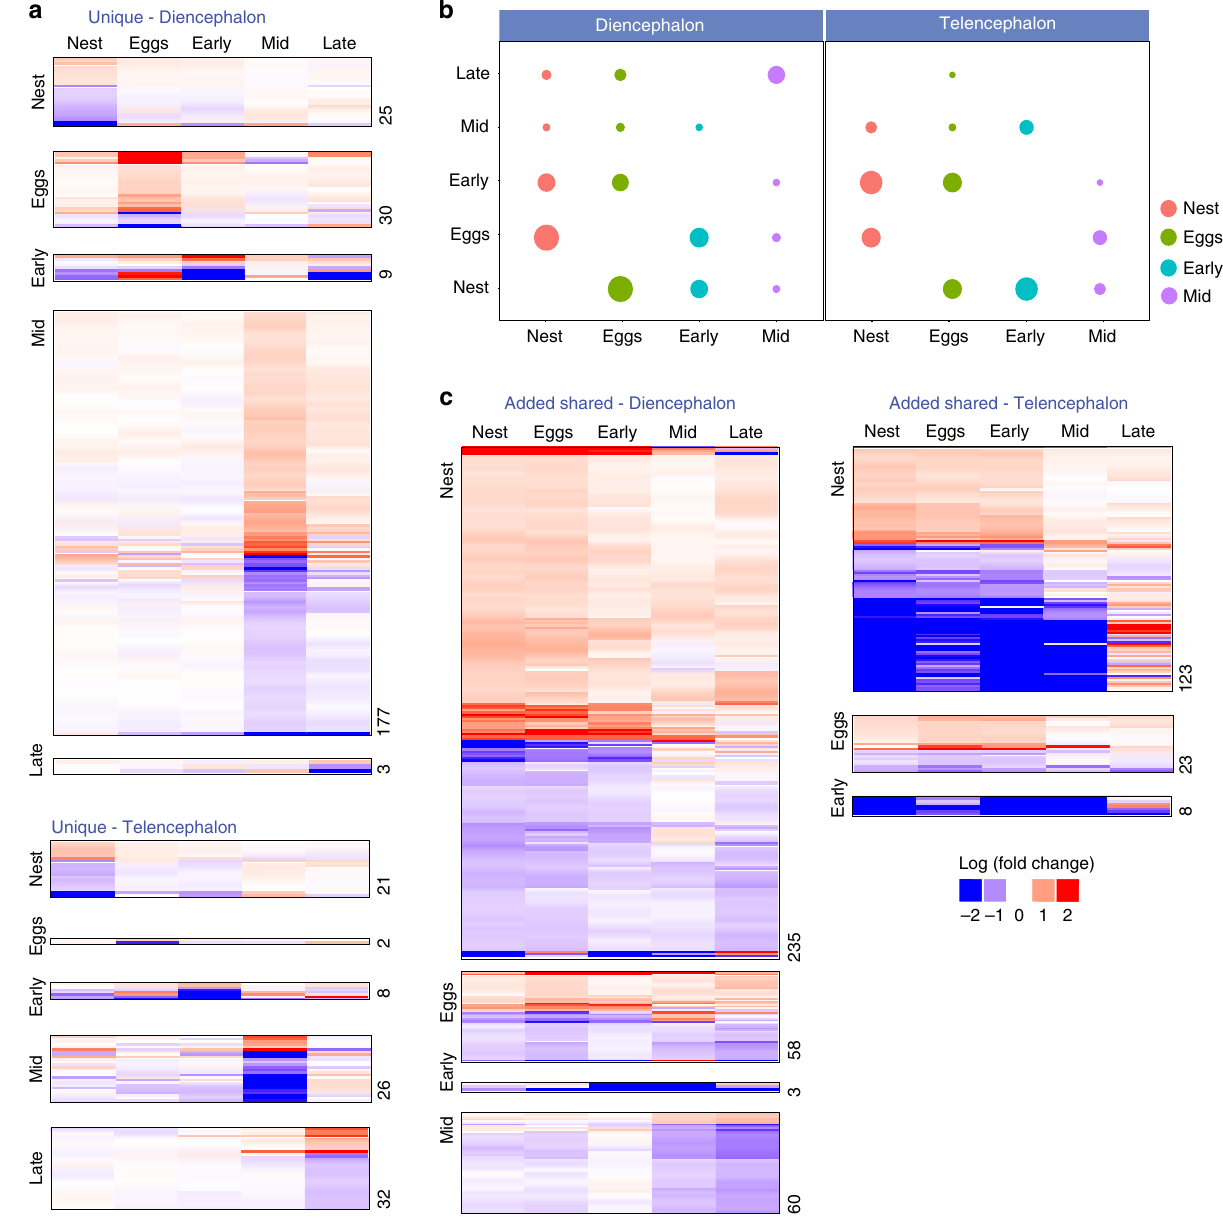
Fig. 2 Change and stability of neurogenomic state across stages of parental care. a There were DEGs that were only differentially expressed during one stage. Shown is a heat map depiction of the expression pro fi le of the genes that were “ unique ” to each stage, showing how they were regulated in other stages, separated by stage and by brain region. b The statistical signi fi cance of the pair-wise overlap between stages within each brain region. The size of the circle is proportional to the signi fi cance of the p-value (hypergeometric test FDR) of the overlap, such that large circles indicate smaller p-values. Note that the stages closest to the focal stage tended to share more DEGs compared to stages further apart in the series. c DEGs that were added to a stage and were also differentially expressed in subsequent stages. Shown is a heat map depiction of the added shared genes for each stage, separated by brain region, showing how they were regulated across stages. Red = upregulated, blue = downregulated. Numbers on the heat maps indicate the number of genes in each heat map. Source data are in GEO